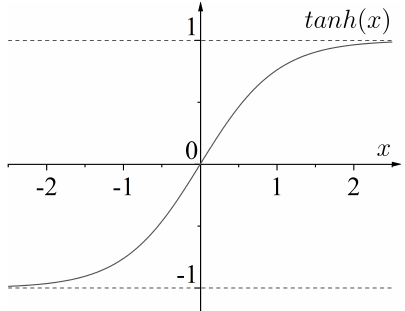
Figure 2. Schematic diagram of tanh ( x )